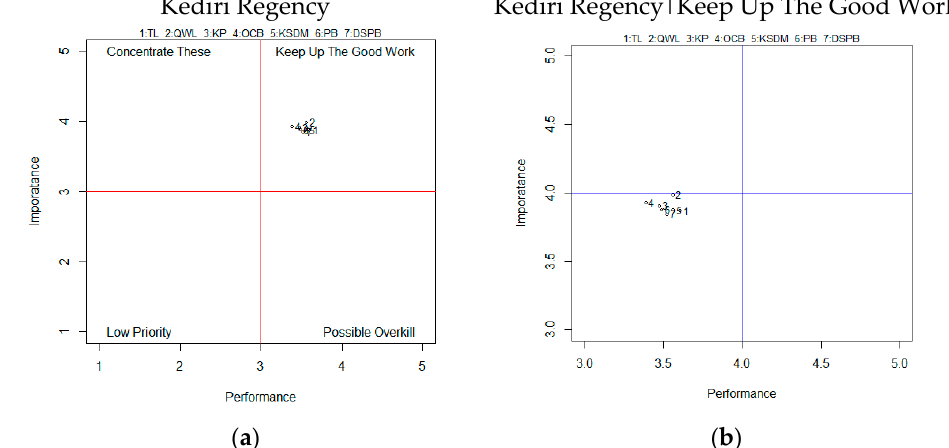
Figure 7. ( a ) IPA Cartesian Diagram of Kediri Regency. ( b ) IPA Cartesian Diagram of Keep up the Good Work Quadrant of Kediri Regency.